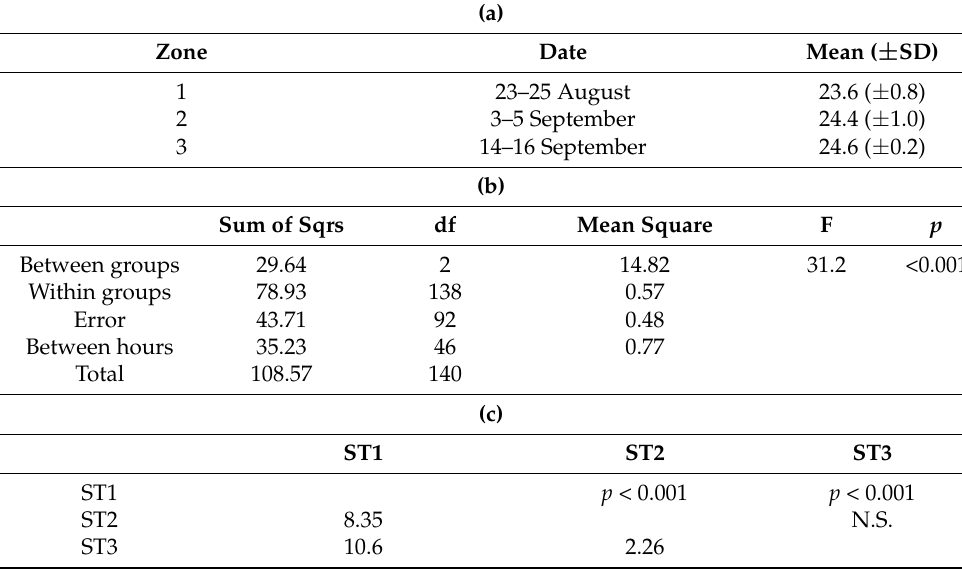
Table 4. (a) Mean ( ± SD) values of temperature ( ◦ C) measured in the three zones of the cave. (b) Results of analysis of variance (ANOVA) on temperature repeated measures in the three zones of the cave. (c) Results of Tukey’s pairwaise test below the diagonal; p values above the diagonal (N.S. = not